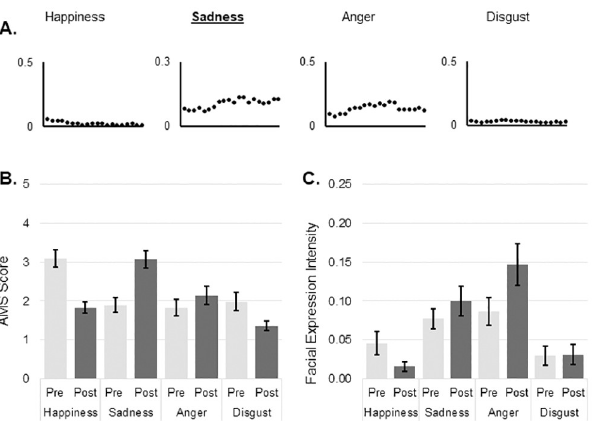
Fig 2. Sadness induction. A: Change in mean values of emotions during the course of video as measured by automated facial expression analysis; B: Mean and SE of subjective mood evaluation as measured by AMS; C: Mean and SE of objective mood evaluation as measured by automated facial expression analysis. AMS: Actual Mood State; SE: Standard Error. https://doi.org/10.1371/journal.pone.0253378.g002 points on happiness scale. Subjective sadness decreased by a mean of 0.589 (p = .004; 95% CI, 0.19 to 0.99) AMS points on sadness scale and subjective anger decreased by a mean of 0.352 (p = .017; 95% CI, 0.07 to 0.64) AMS points on anger scale (Fig 1B). There was no statistically significant two-way interaction between group and time of assess- ment on subjective arousal estimates, but there was a significant main effect of time of assess- ment (F = 8.403, p = .005, partial η 2 = .133). Subjective arousal was significantly higher (1, 55) after emotion induction (mean difference 0.40, 95% CI 0.12 to 0.68). There was also a signifi- cant main effect of group (F = 7.911, p = .007, partial η 2 = .126) on arousal. YA group (1, 55) rated their arousal higher than OA group (mean difference 0.74, 95% CI 0.21 to 1.27). Facial expression. There was no statistically significant three-way interaction between emotion, time and group. A two-way interaction between emotion and time of assessment was = 22.469, p < .001, partial η 2 = .298. Intensity of facial happiness significant, F (1.809, 95.882)